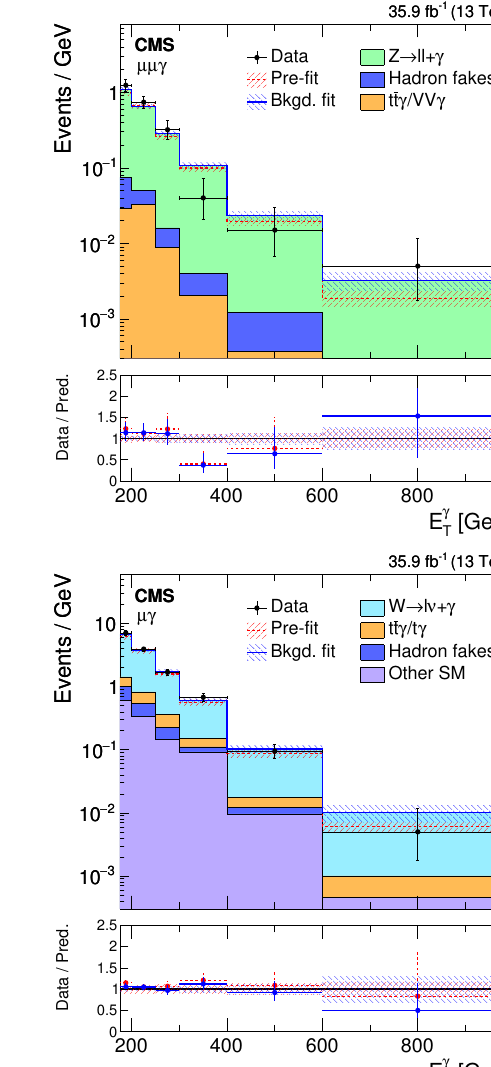
mediator scenarios, in the M med { m DM plane. The solid black (dashed red) curves are the observed (expected) contours of (cid:22) 95 = 1. The (cid:27) theory hypothesis is excluded at 95% CL or